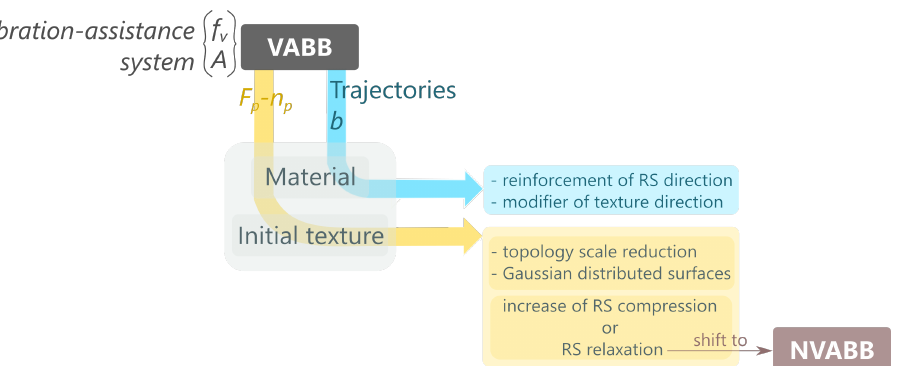
Figure 3. Recommended protocol to be followed to design the VABB processing